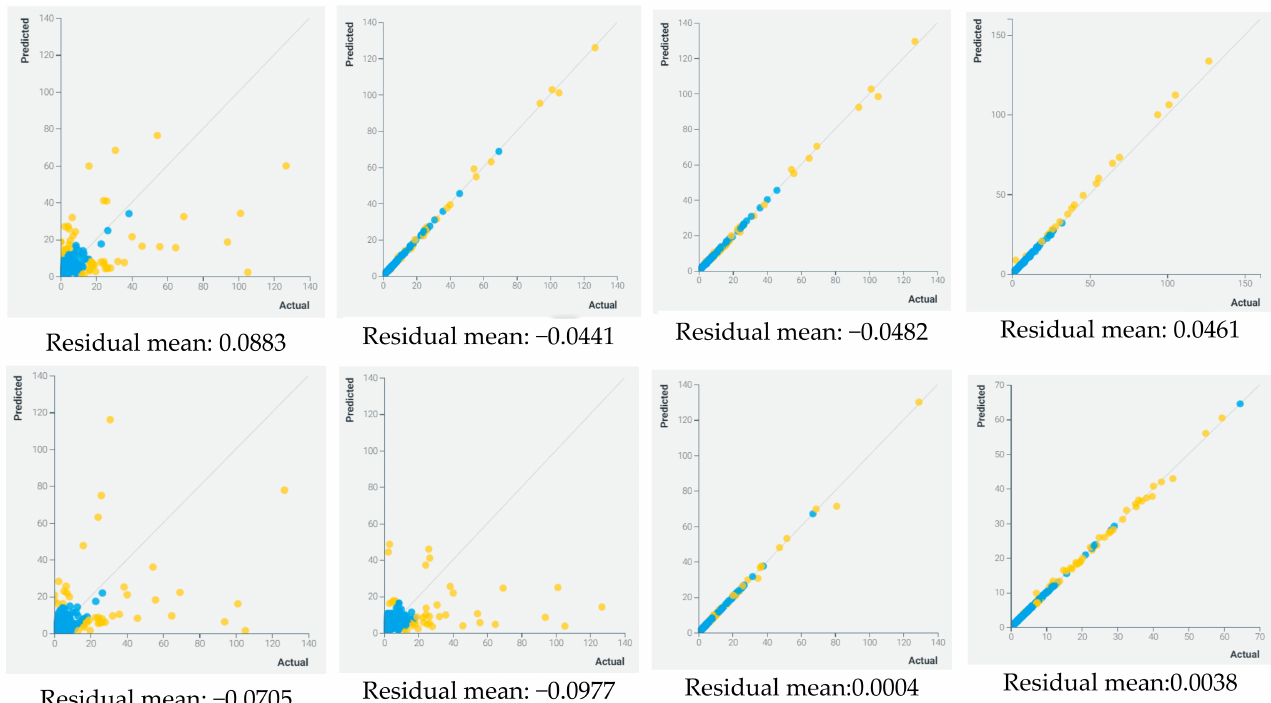
Figure 6. Residuals of different models (yellow represent expected outputs and blue ground- truth